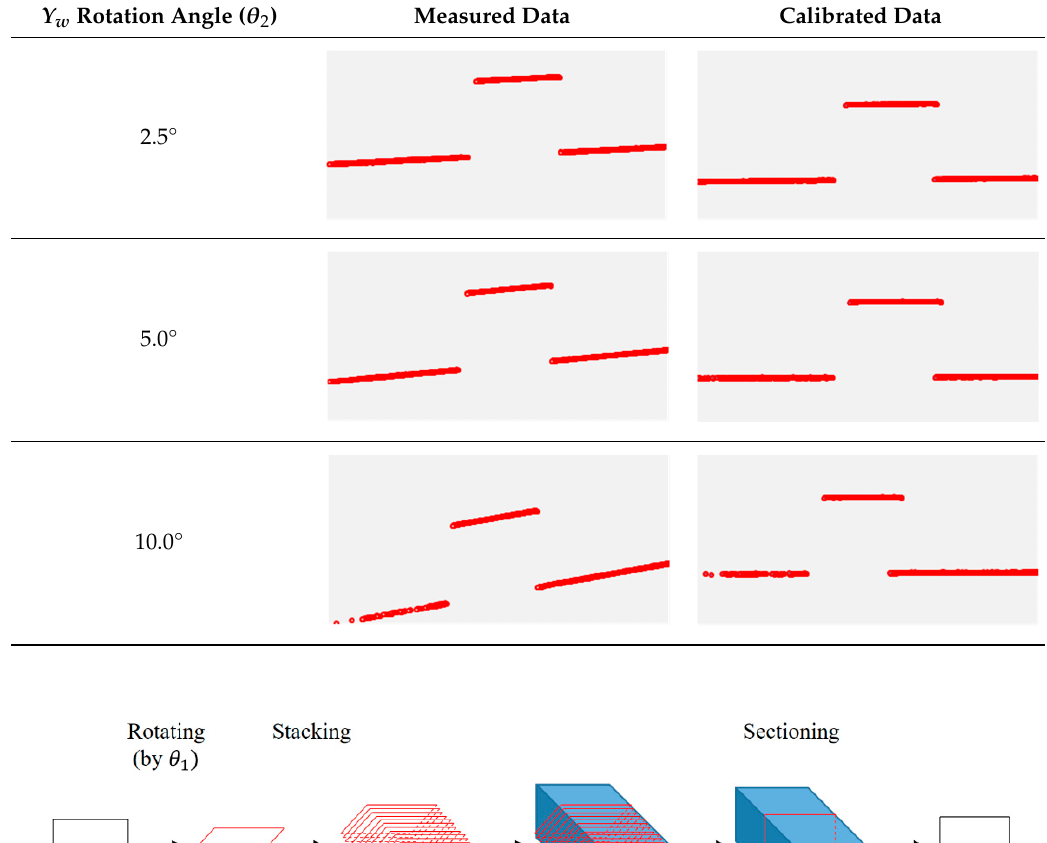
Table 4. Calibration results for the Y w rotation error.